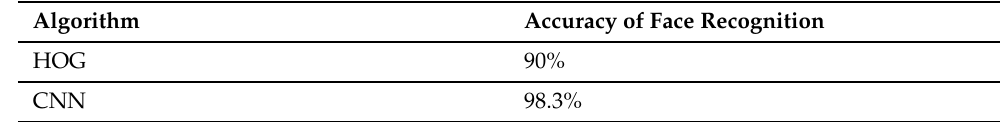
Table 7. Accuracy of HoG and CNN while using images with face